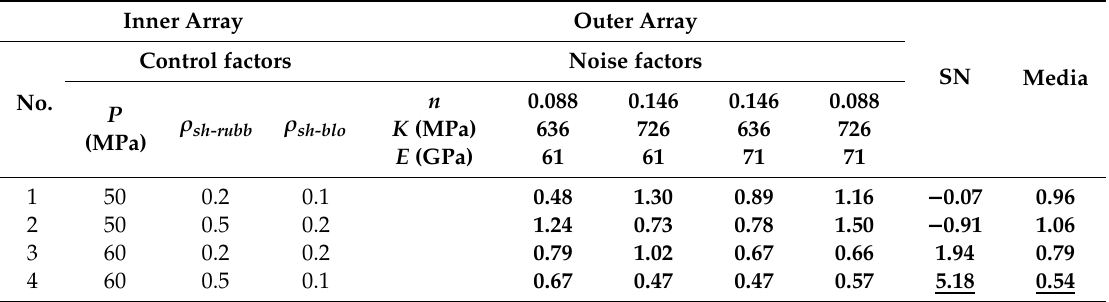
Table 5. Values of the multiple optimization function (the results are represented in the values in bold). Inner